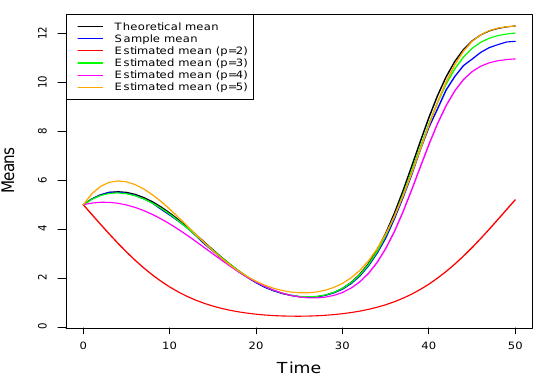
Example 2. Theoretical, sample and estimated mean functions. s =0.025